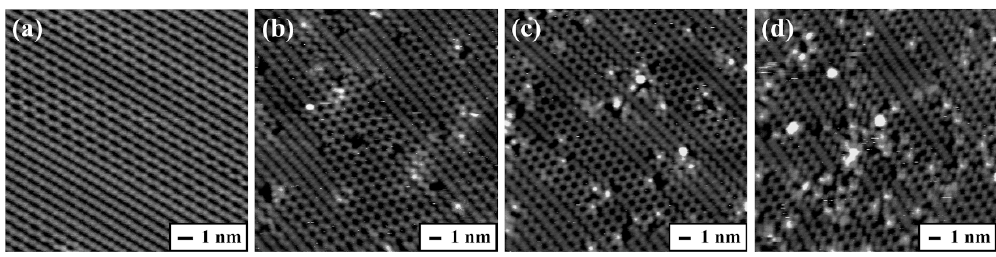
Figure 3. Representative filled-state STM images of ( a ) clean Ge(100) surface, ( b ) 0.016, ( c ) 0.035, and ( d ) 0.066 ML proline adsorbed onto the Ge(100) surface at room temperature. The individual deposition times under the same deposition conditions are ( b ) 60, ( c ) 180, and ( d ) 480 s. The adsorbed proline on the Ge(100) surface appears as bright protrusions in the STM images. The scan area of the STM images are ( a ) 16.0 × 16.0, ( b ) 20.0 × 20.0, ( c ) 20.0 × 20.0, and ( d ) 20.0 × 20.0 nm 2 .